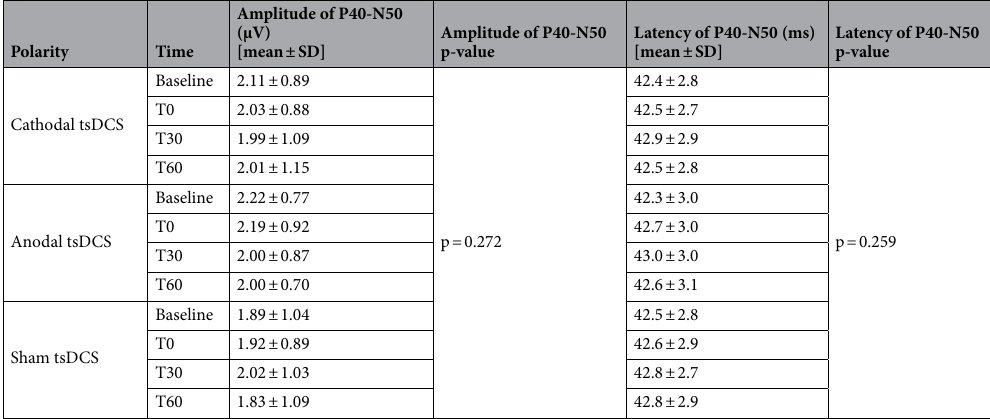
Table 2. Amplitudes and latencies of single stimulations. Amplitudes (µV) and latencies (ms) (mean ± SD) of P40-N50 peak of tibial nerve SEP. SEPs were recorded before (baseline), immediately (T0) as well as 30 (T30) and 60 min (T60) after tsDCS. P-values were calculated using a Greenhouse–Geisser-corrected rmANOVA for the interaction polarity*time; n = 14.